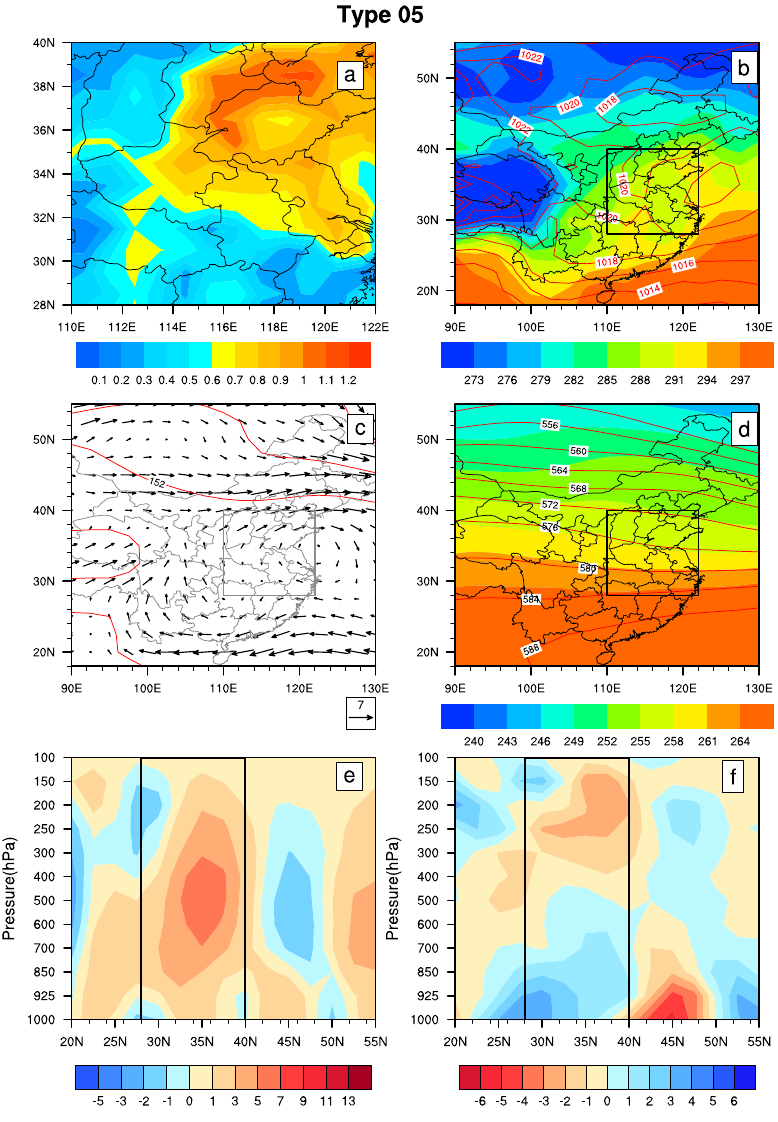
Figure 12. As in Fig. 8 but for Type 5